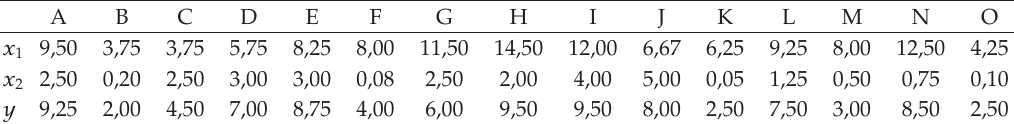
Table 2: Data for the two inputs single output